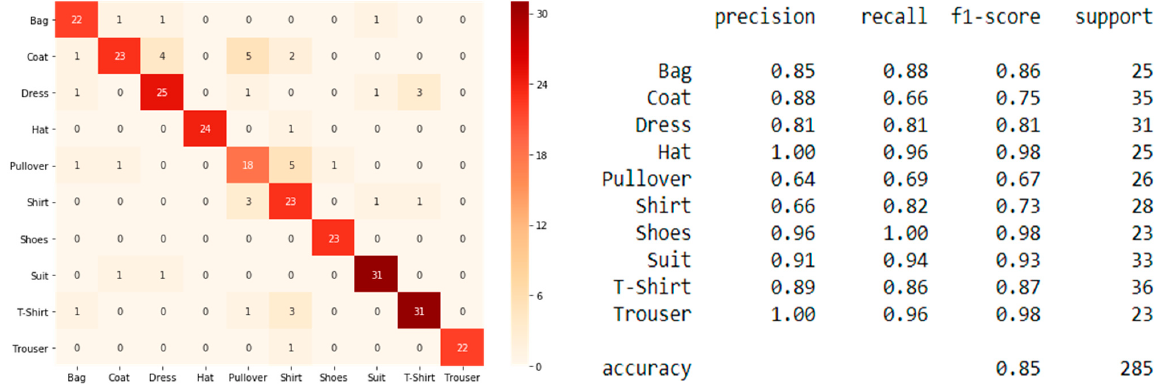
Figure 20. The left sub-image depicts the confusion matrix that was calculated for the transferred VGG-16. The right sub-image depicts the classification report of the transferred VGG-16 model.